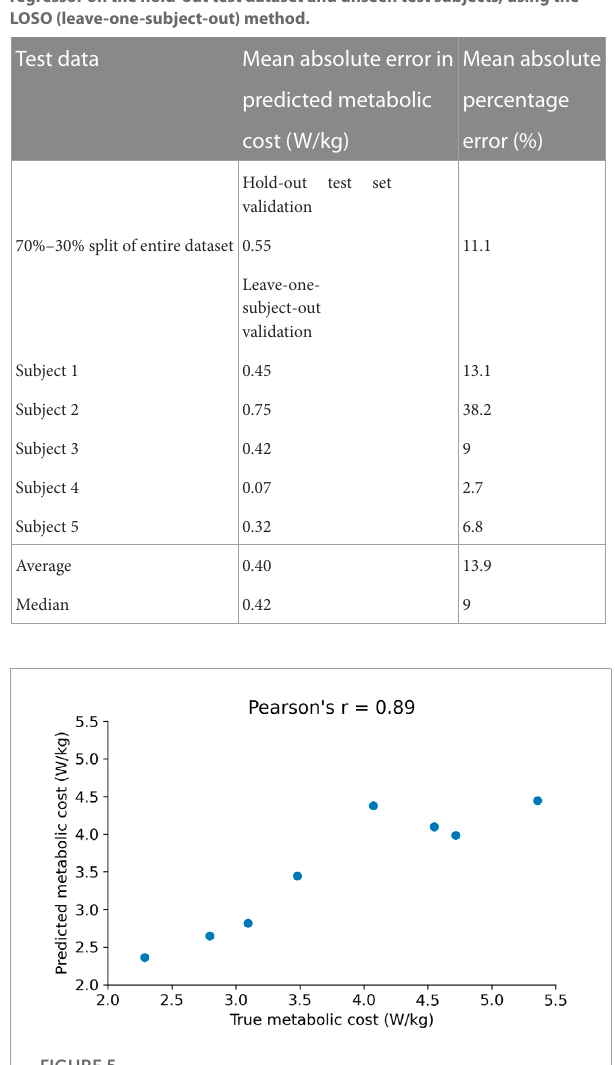
FIGURE 5 Correlation between the true metabolic cost and the cost predicted by the random forest model using foot pressure